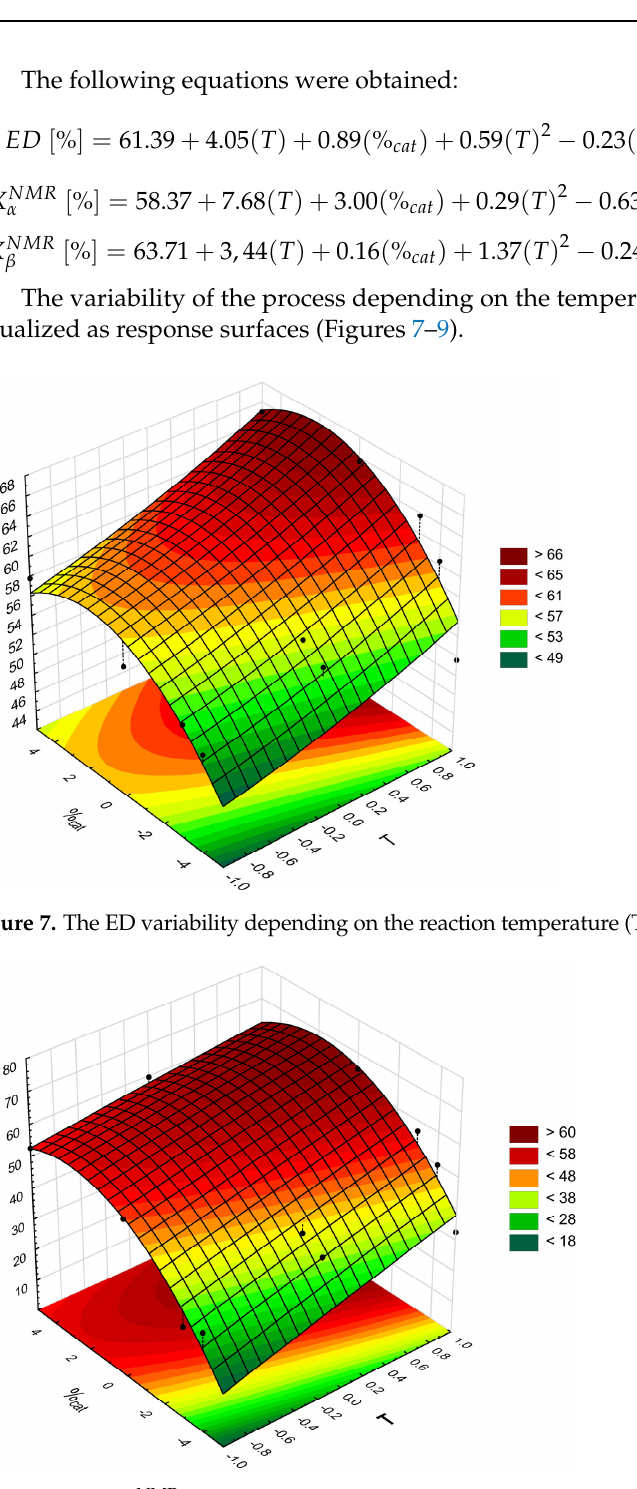
Figure 8. The X α NMR variability depending on the reaction temperature (T) and the catalyst content (% cat ).